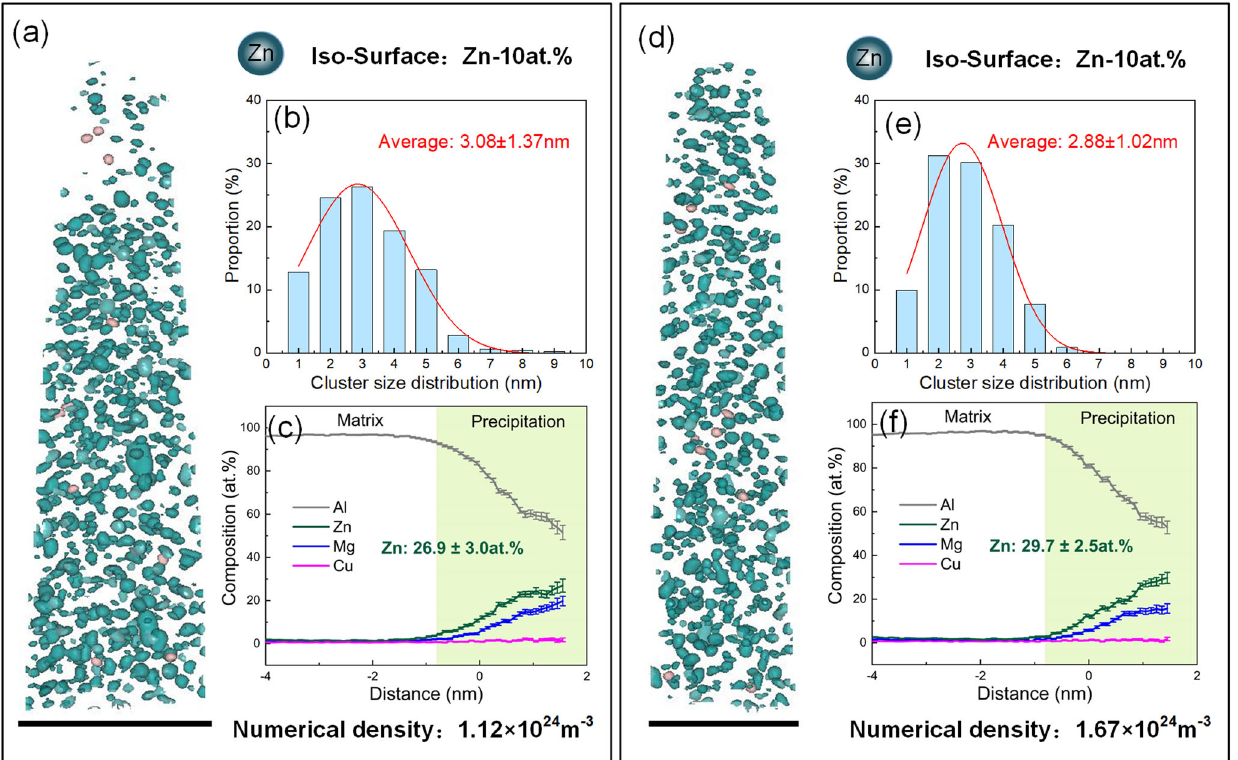
Fig. 6 The three-dimensional distribution of precipitates with the APT analysis. a 3D reconstruction topography in the HT0 sample, b size distribution in the HT0 sample, c composition change in the HT0 sample; d 3D reconstruction topography in the T66R sample, e size distribution in the T66R sample, f composition change in the T66R sample. Scale bars: 76 nm ( a ), 58 nm ( d